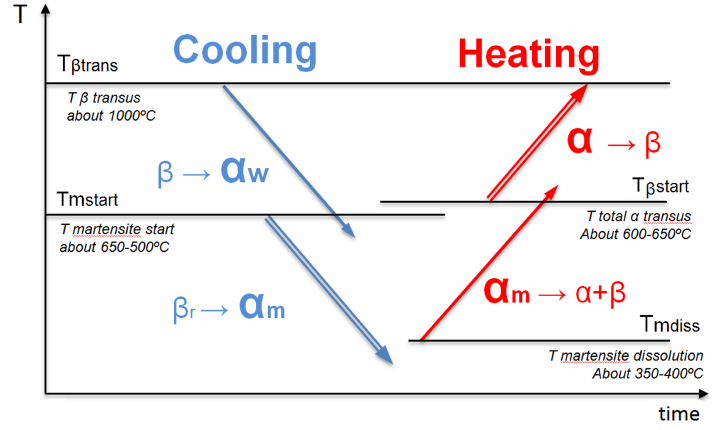
Figure 3. Schematic representation of the 4 main solid state transformation considered in the proposed model.